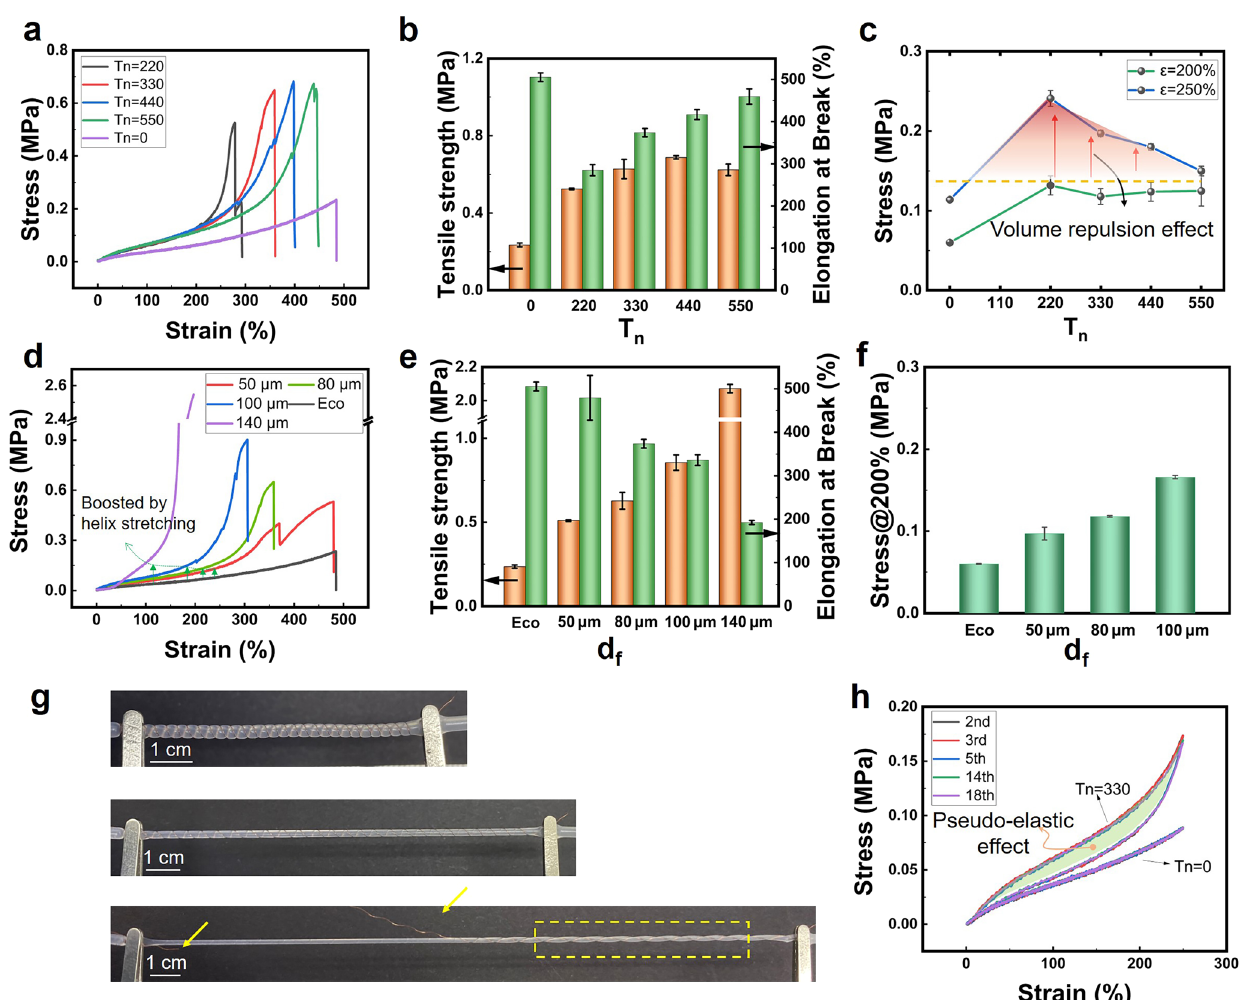
Fig. 3 The mechanical properties and pseudo-elastic behavior of the HFCs. a The stress – strain curves for the HFC with different T n . b The tensile strength and elongation at break for the HFC with different T n . c The stress of HFC with different T n at the strain of 200% and 250%. d , e Stress – strain curves, tensile strength, and elongation at break for the HFC wrapped with different sized Cu wires but with the same T n of 330, respectively. f The effects of Cu wire diameter on the stress of HFC at the pre-stretched strain of 200%. g Photograph of HFC during stretching. One can fi nd that, even after the failure of Cu wire as indicated by the yellow arrow, the unbroken part of the wire is still coupled with the elastomer (see the yellow square region). h The mechanical hysteresis phenomenon caused by pseudo-elastic behavior of the HFC as revealed by the cycling testing of loading-unloading. All the samples were tested at room temperature with a stretching speed of 100 mm min − 1